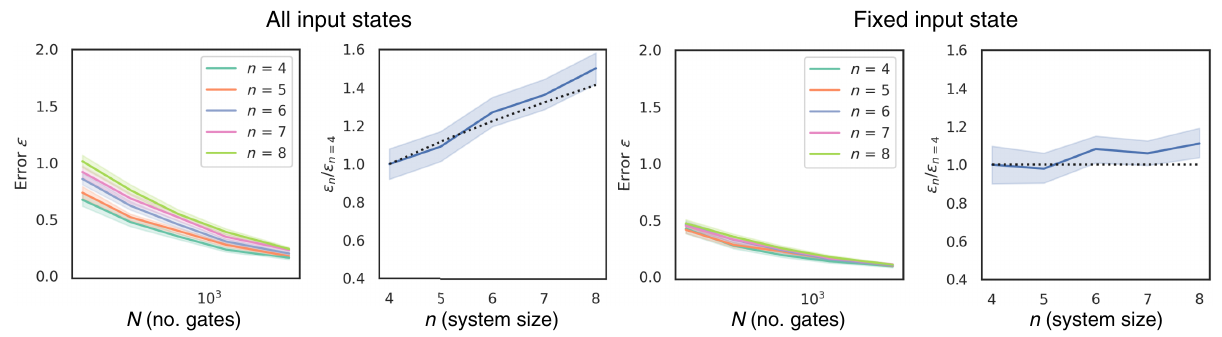
FIG. 3. Numerical experiments for simulating 1D Heisenberg model under different gate count N . In All input states (left), we consider (cid:2) = (cid:3) U − V N . . . V 1 (cid:3) ∞ , which considers the error over all input states and observables. In Fixed input state (right), we , which considers the error over all observables. The input state | ψ (cid:9) is chosen to be the tensor consider (cid:2) = (cid:3) U | ψ (cid:9) − V N . . . V 1 | ψ (cid:9)(cid:3) (cid:14) 2 product of single-qubit Haar-random states. For both All input state and Fixed input state , we give an additional plot showing how the error (cid:2) increases as the system size n increases for a fixed number of gates N = 160. The y -axis is normalized using the average error for system size n = 4 over 50 independent runs. Bounds in Theorems 1 and 2 show that the relative error (cid:2) n /(cid:2) n = 4 scales as All input state and stays as constant 1 for Fixed input state , which are shown as the dotted lines. The shaded regions are the standard deviation over 50 independent